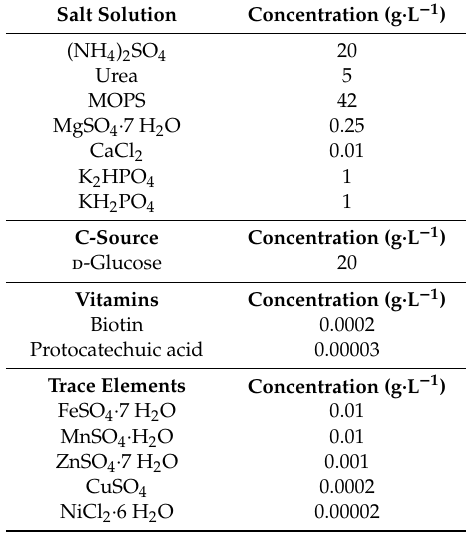
Table A1. CgXII medium (modified from [49]) for the cultivation of C. glutamicum strains. Cultivations with pH control (pH 7) were performed with MOPS-free CgXII medium.